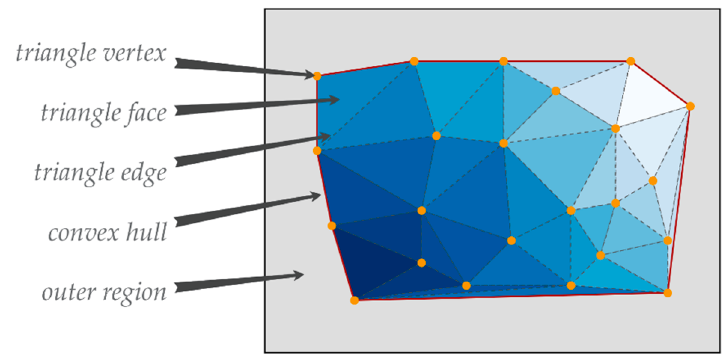
Figure 2. Example of a Triangulated Irregular Network (TIN) with the adopted nomenclature for the various components.